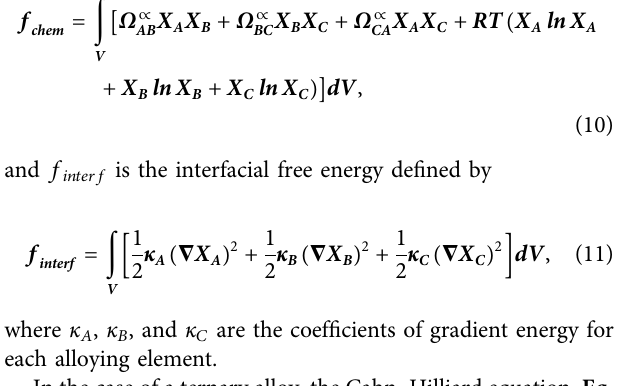
Frontiers in Materials |